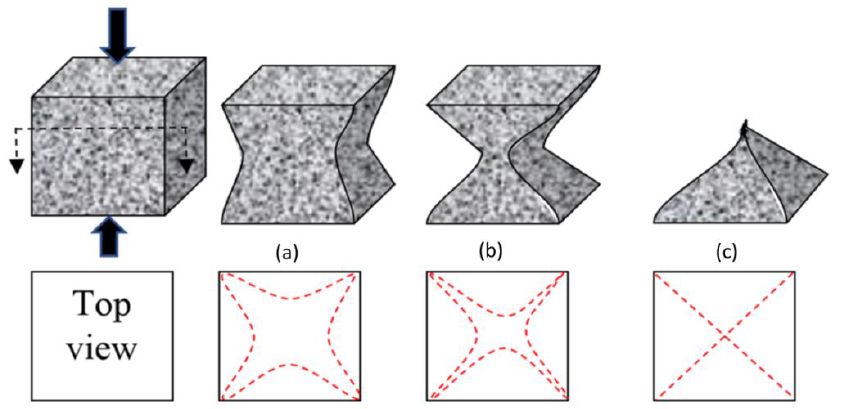
Figure 7. Typical crack patterns in the cube samples. ( a ) A non-explosive pattern, ( b ) a semi-explosive pattern, and ( c ) an explosive pattern.